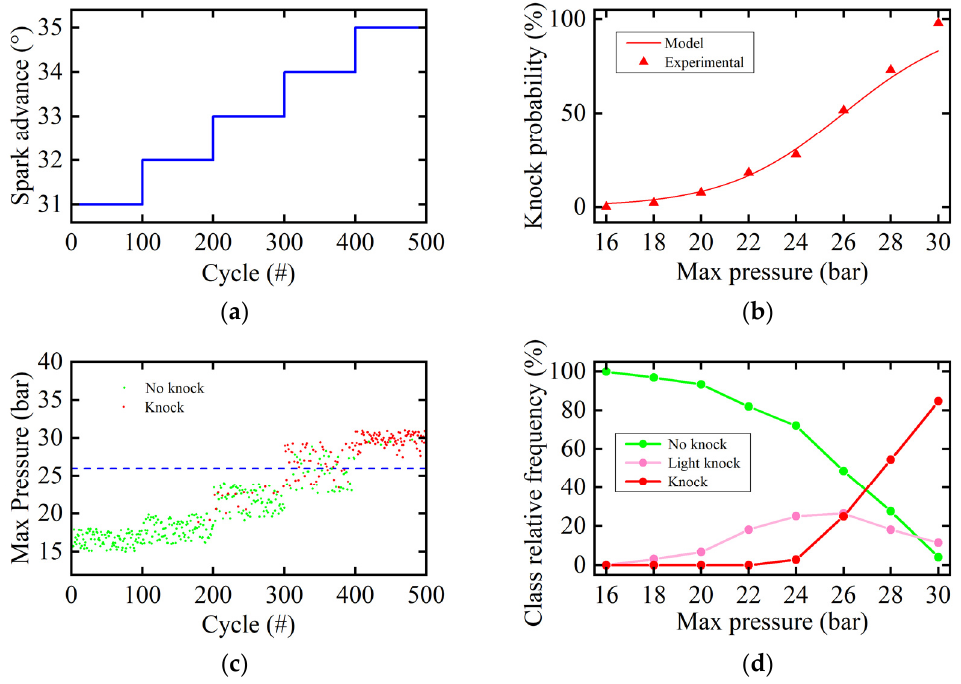
Figure 4. Example of kerosene engine knock-prediction model.